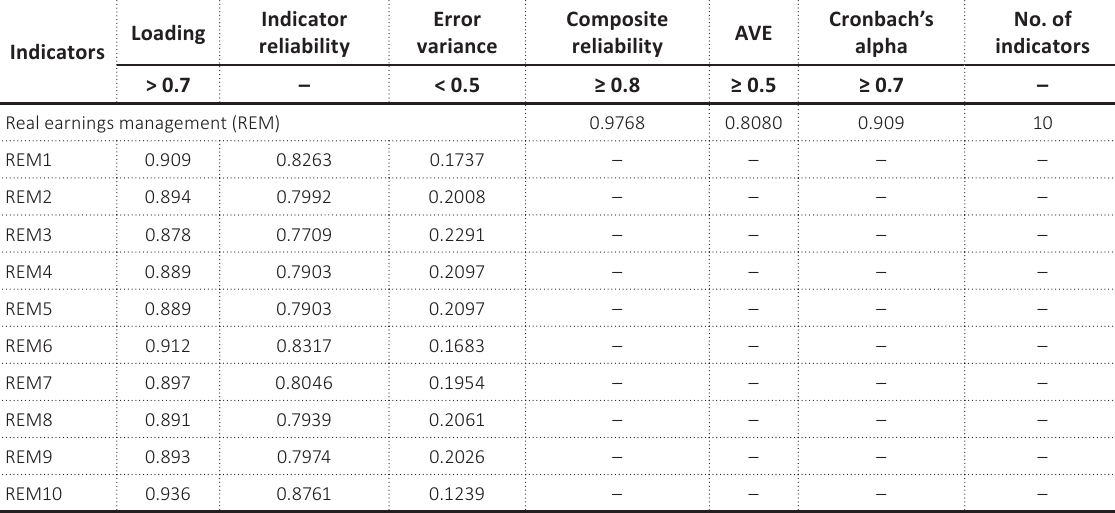
Source: Field survey (2019).